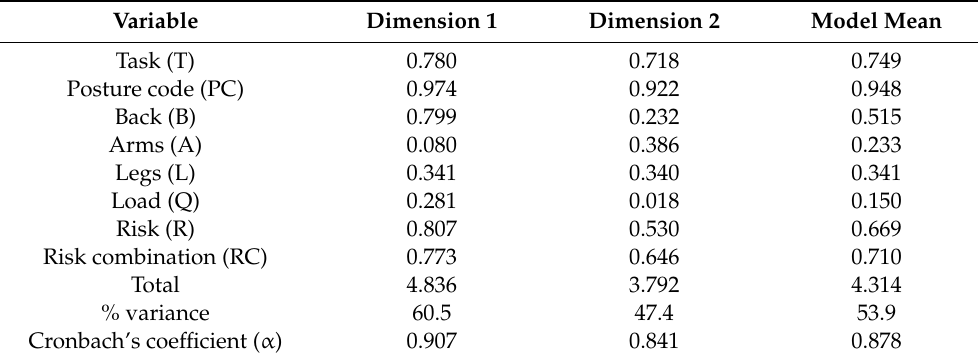
Table 10. Discrimination measures of the variables.